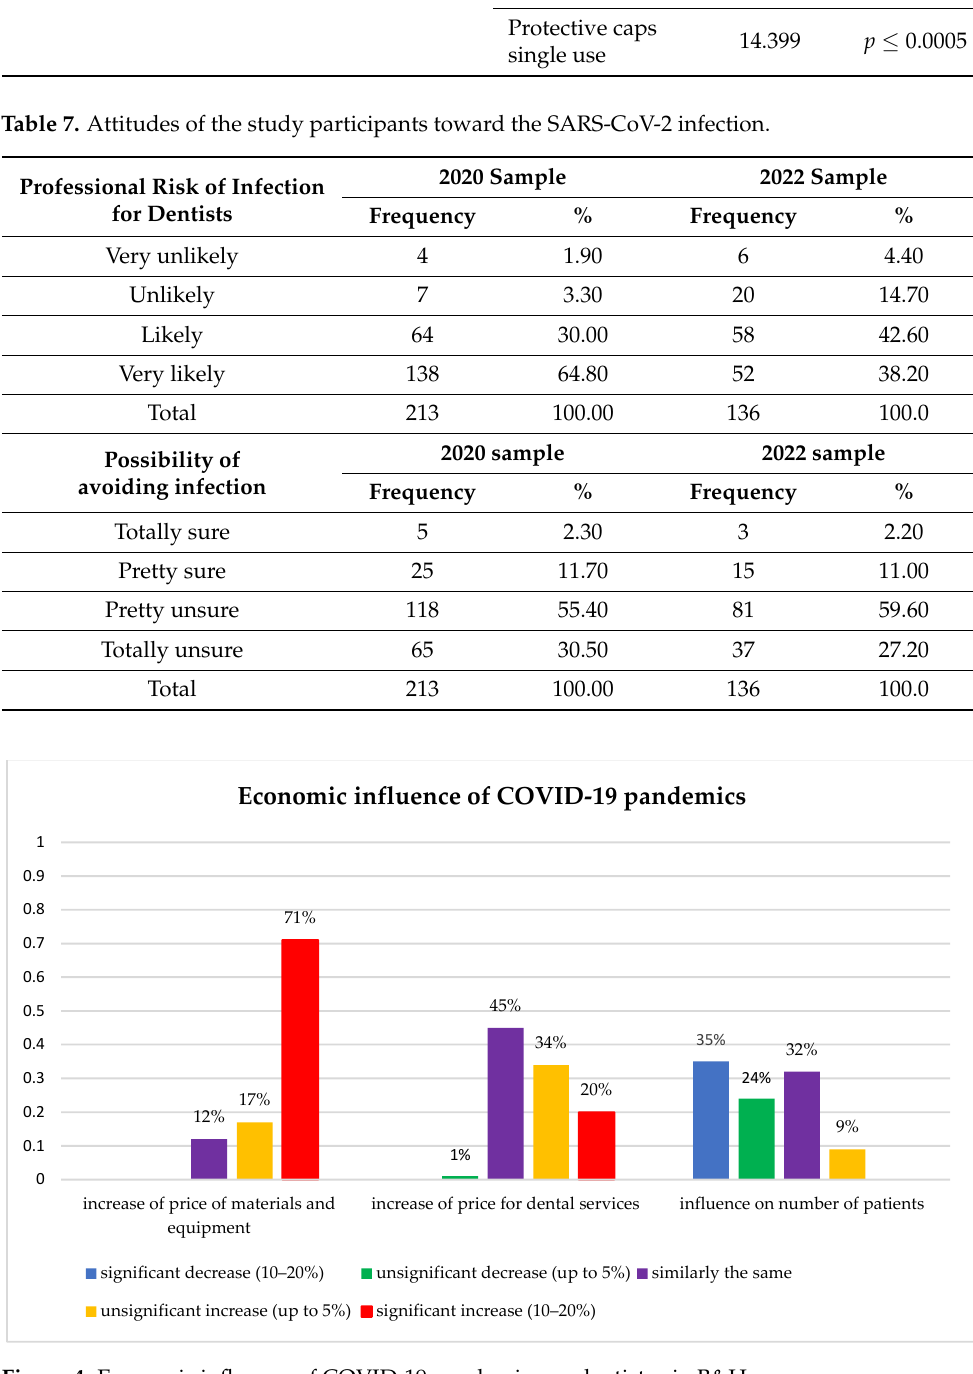
Figure 4. Economic influence of COVID - 19 pandemics on dentistry in B&H.